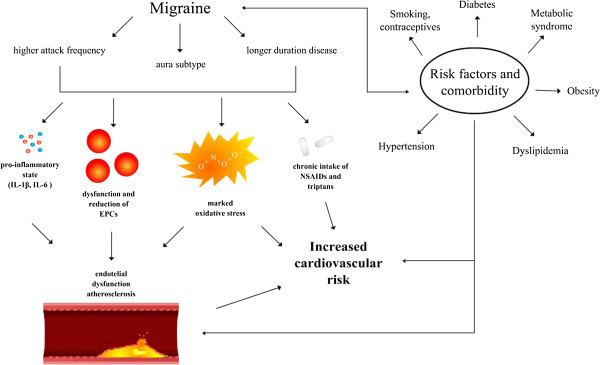
Putative mechanisms which may increase the risk of vascular events in patients with migraine. EPCs Endothelial Progenitor Cells; NSAIDs Non-steroidal anti-inflammatory drugs.